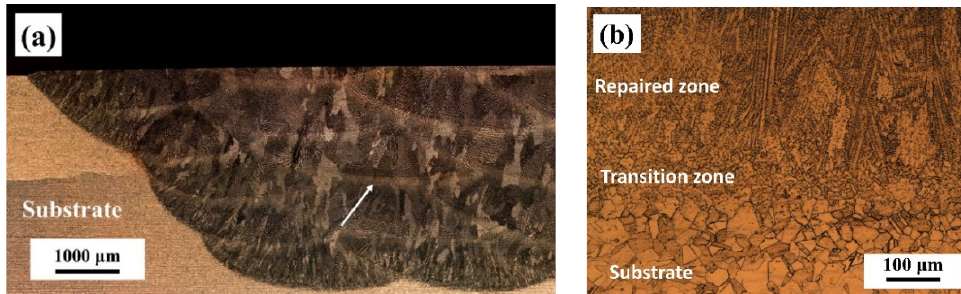
Figure 3. Cross-sectional microstructure of the repaired Inconel 718 alloy specimen: ( a ) at low magnification and ( b ) at high magnification.